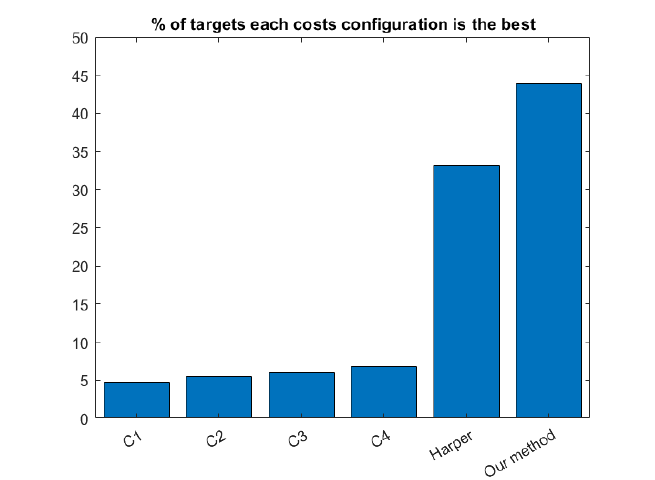
Figure 6. Percentage of times that each set of costs returns the best classification ratio. Tables 7 and 8 show our learned edition costs for nodes and edges, respectively. In red and bold are the ones that are different to the ones proposed by Harper et al. [33]. As we can see, the results are very similar to Harper costs because we introduce a very small modification in each step. In addition, there are many costs that have not been modified. − D improperly classified, minimising D (cid:48) i . i Table 7. Substitution, insertion and deletion costs of nodes obtained with our method. In bold, the ones that are different from Tables 3 and 4. Substitution Costs for